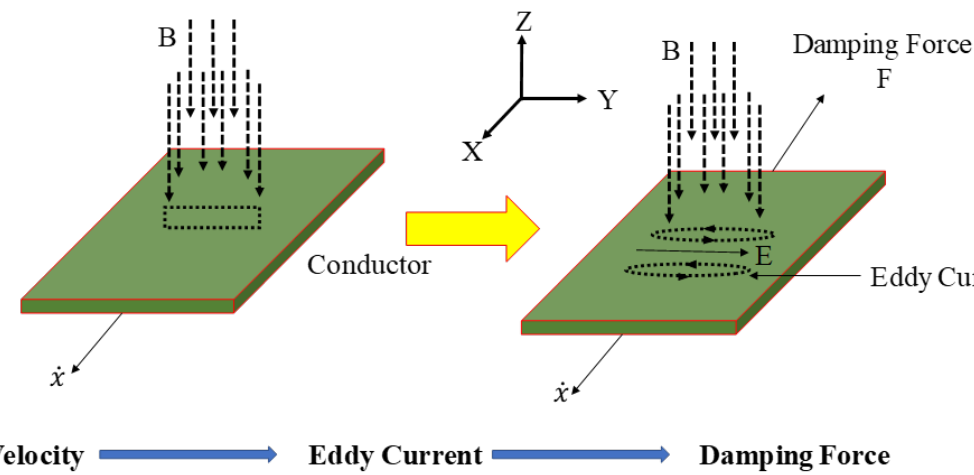
Figure 3. Electromagnetic damping principle.